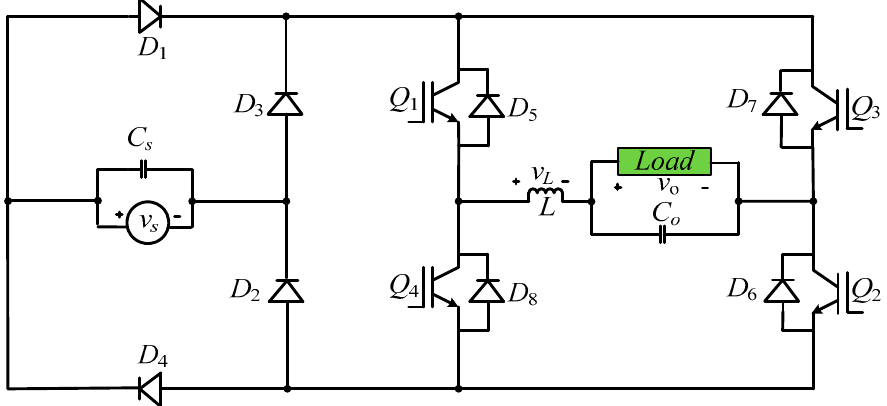
Figure 2. Proposed compact size bipolar voltage gain AC–AC converter.